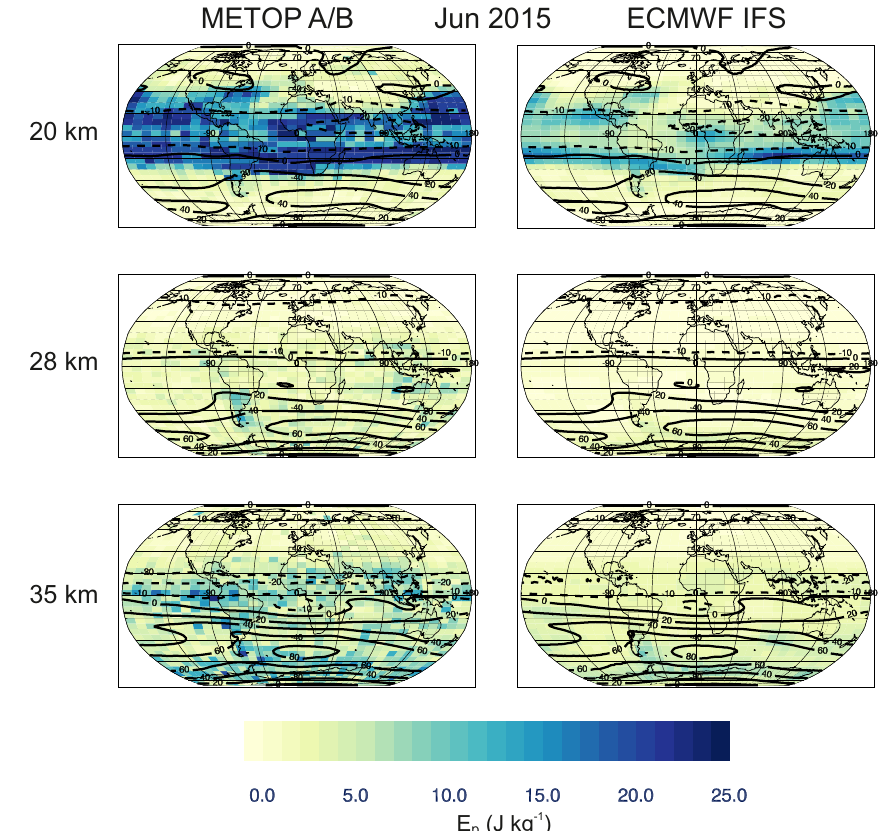
Figure 12. Same as Fig. 11 but for June